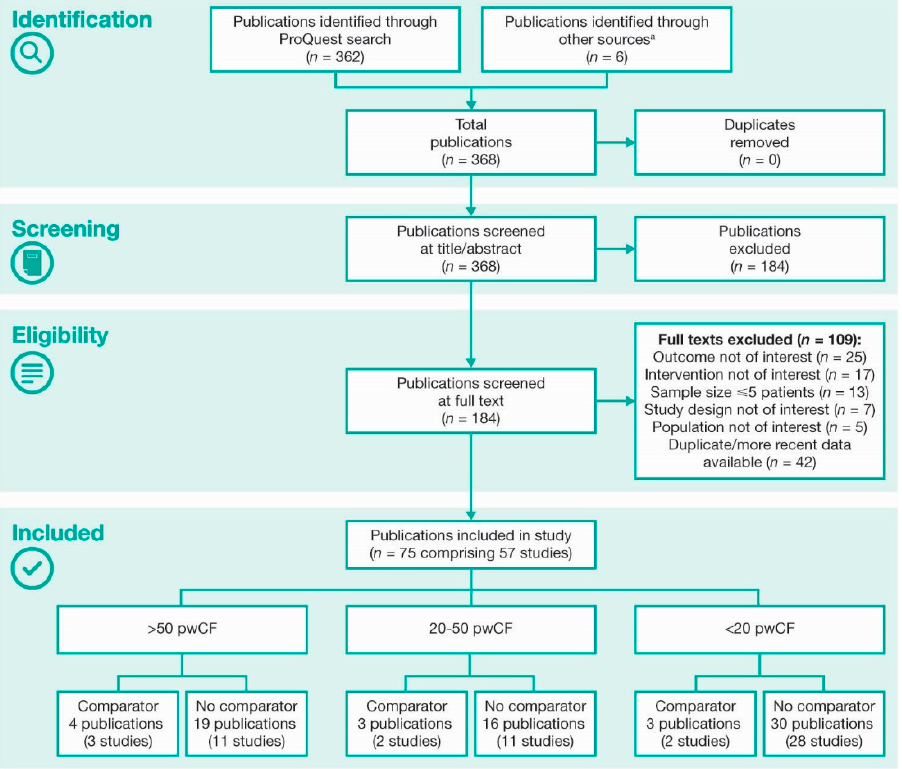
Figure 1. Identification of Publications According to PRISMA Guidelines. a Identified via European Cystic Fibrosis Society Conference summaries. PRISMA: Preferred Reporting Items for Systematic Reviews and Meta-Analyses; pwCF: people with cystic fibrosis.